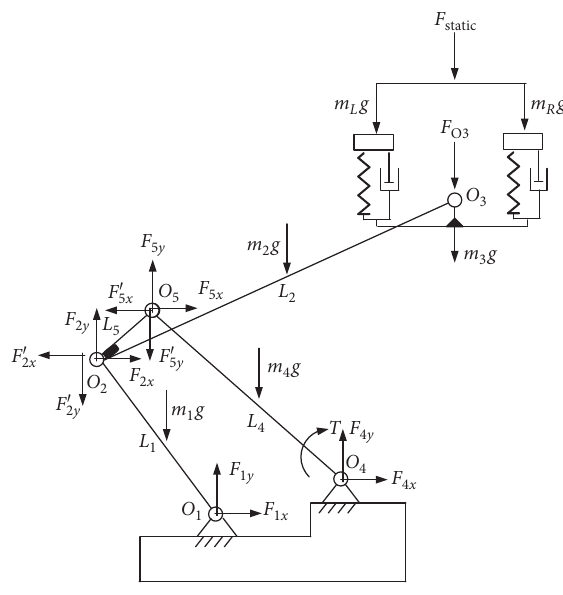
Figure 15: Static force